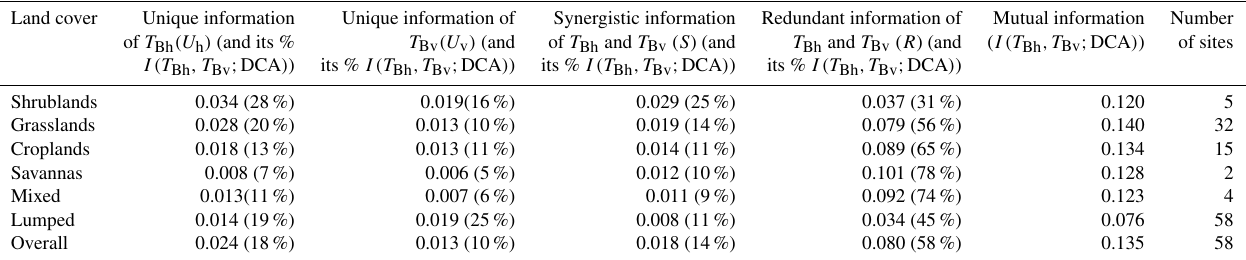
Table 2. The partial information decomposition components. The values in the table are the average of each land cover. The values in “Overall” are the average of all the sites. The “Lumped” field is computed using all available datasets. Land cover Unique information Unique information of Synergistic information Redundant information of Mutual information Number of T Bh (U h ) (and its % T Bv (U v ) (and of T Bh and T Bv ( S ) (and T Bh and T Bv ( R ) (and ( I(T Bh ,T Bv ; DCA ) ) of sites I(T Bh , T Bv ; DCA ) ) its % I(T Bh ,T Bv ; DCA ) ) its % I(T Bh ,T Bv ; DCA ) ) its % I(T Bh ,T Bv ; DCA ) ) Shrublands 0.034 (28%) 0.019(16%) 0.029 (25%) 0.037 (31%) 0.120 5 Grasslands 0.028 (20%) 0.013 (10%) 0.019 (14%) 0.079 (56%) 0.140 32 Croplands 0.018 (13%) 0.134 15 Savannas 0.013(11%) 0.007 (6%) 0.011 (9%) 0.092 (74%) 0.123 4 Lumped 0.014 (19%) 0.019 (25%)